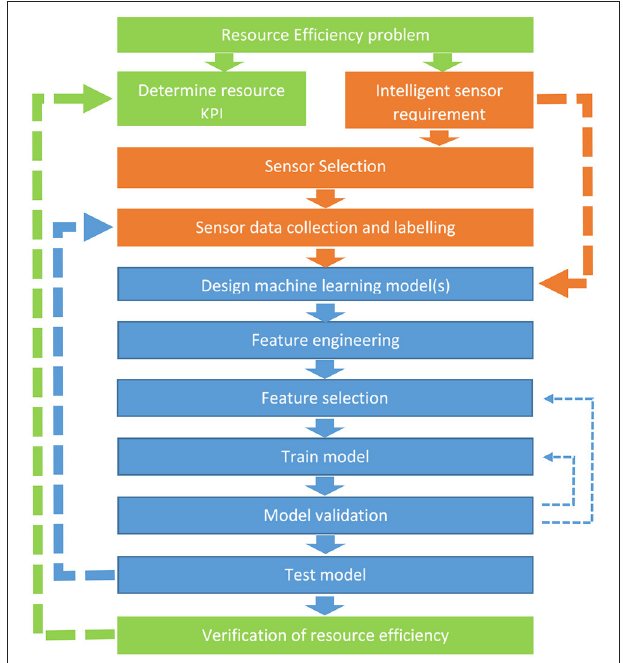
FIGURE 1 | Intelligent sensing process for resource efficiency. The steps in the green boxes are directly related to the resource efficiency problem, the orange boxes to the sensor aspects and the blue to the machine learning process. Solid arrows indicate the main direction of methodology, thick dashed lines indicate scenarios that require a return to a previous step and thin dashed arrows indicate stages that will undergo iterative